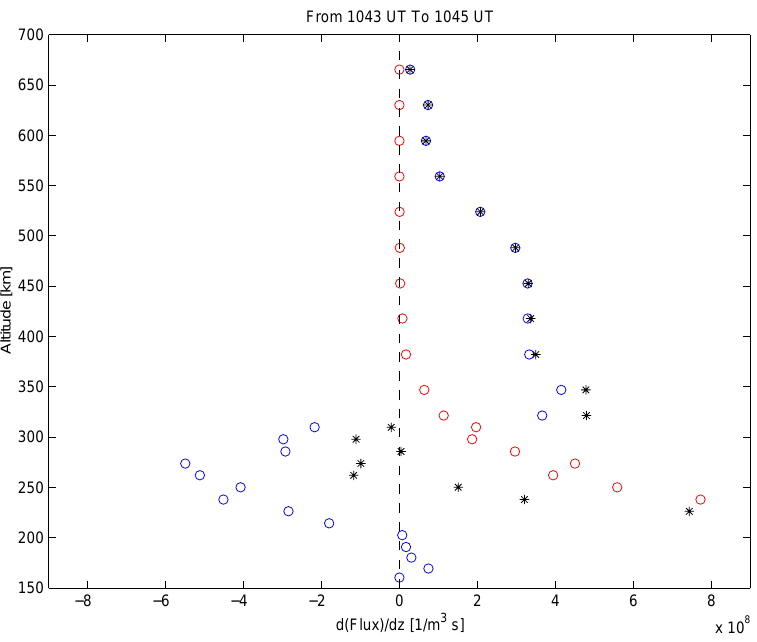
Fig. 4. Profiles of the flux gradient ∂F i /∂s (blue circles), the negative estimated recombination rate − L (red circles) and the resulting production rate Q = ∂F i /∂s + L (asterisk) on 8 July 1999, from 10:43 until 10:45UT.